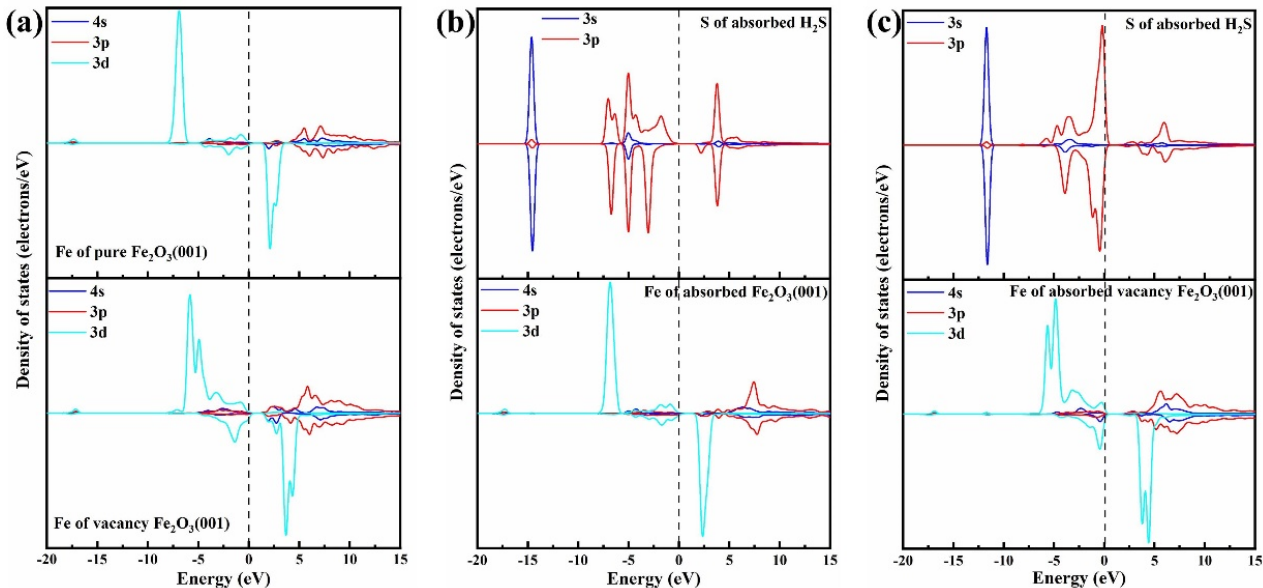
Figure 6. ( a ) The PDOS of Fe atoms on the pure and vacant α -Fe 2 O 3 (001) surface before adsorption; ( b ) the PDOS of pure α -Fe 2 O 3 (001) surface of Fe atom and S atom of H 2 S after adsorption; and ( c ) the PDOS of Fe atom and S atom of H 2 S on the surface of the adsorbed vacancy α -Fe 2 O 3 (001).